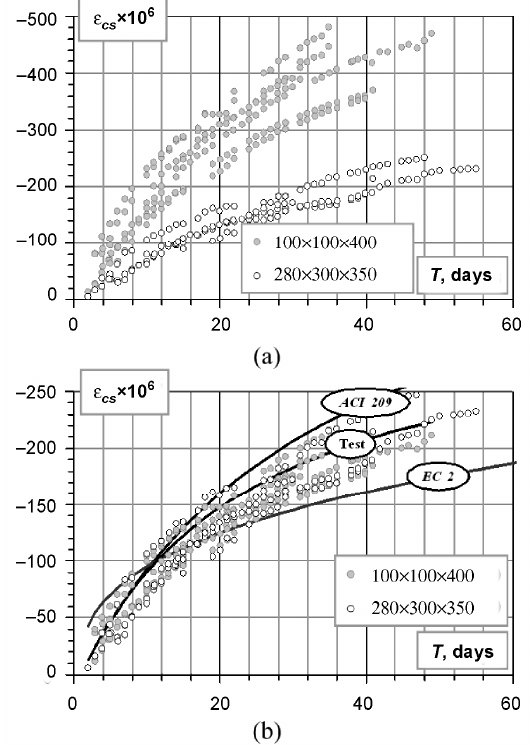
Fig. 3. Free shrinkage deformations: measured in different size prisms (a) and reduced to size of test beams (b) Table 5. Size factor (converting shrinkage strain from 100 ×